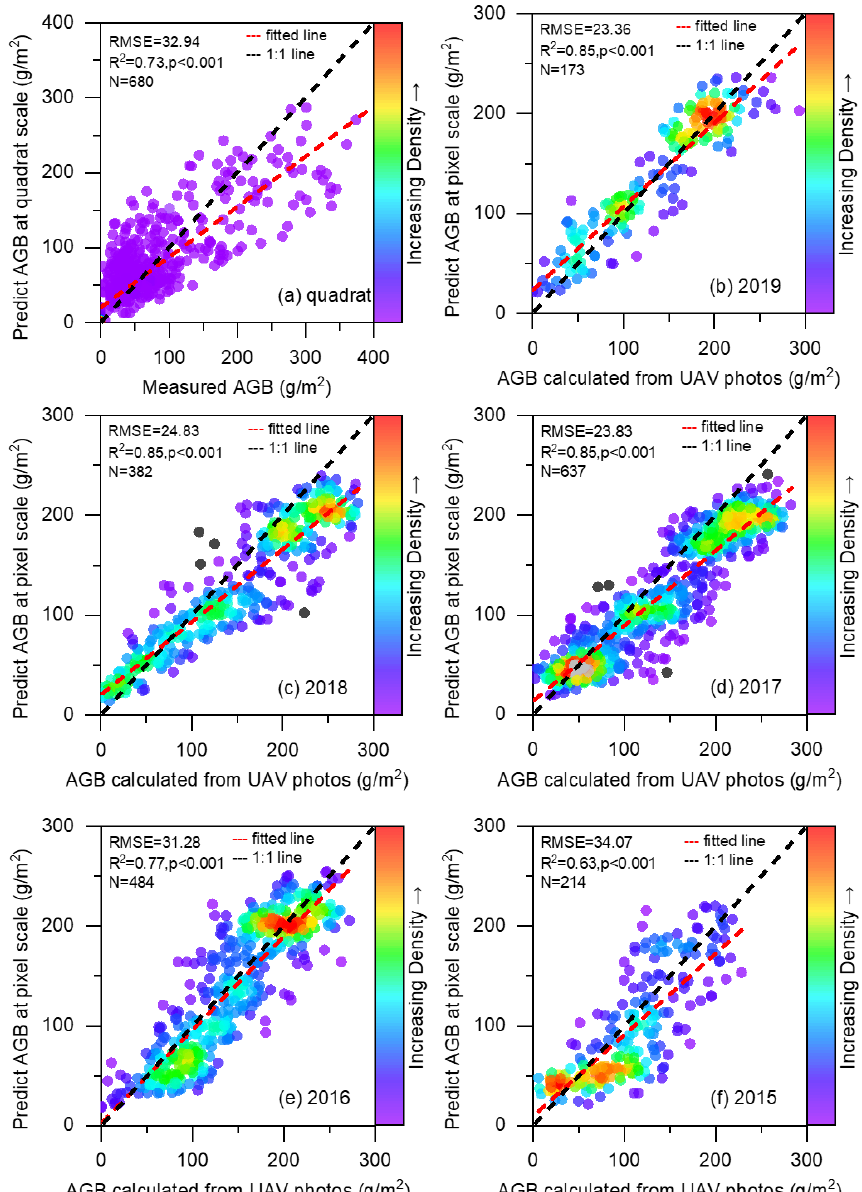
Figure 6. Validation results of the AGB estimation models at the quadrat (a) and MODIS pixel scale for 2015–2019 (b–f) .